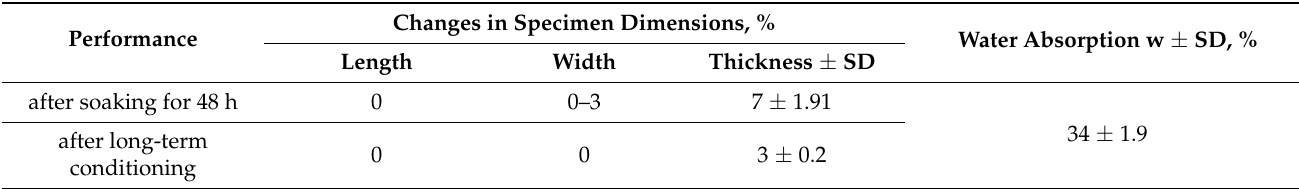
Table 2. The results of dimensional changes in the specimens and water absorption levels.